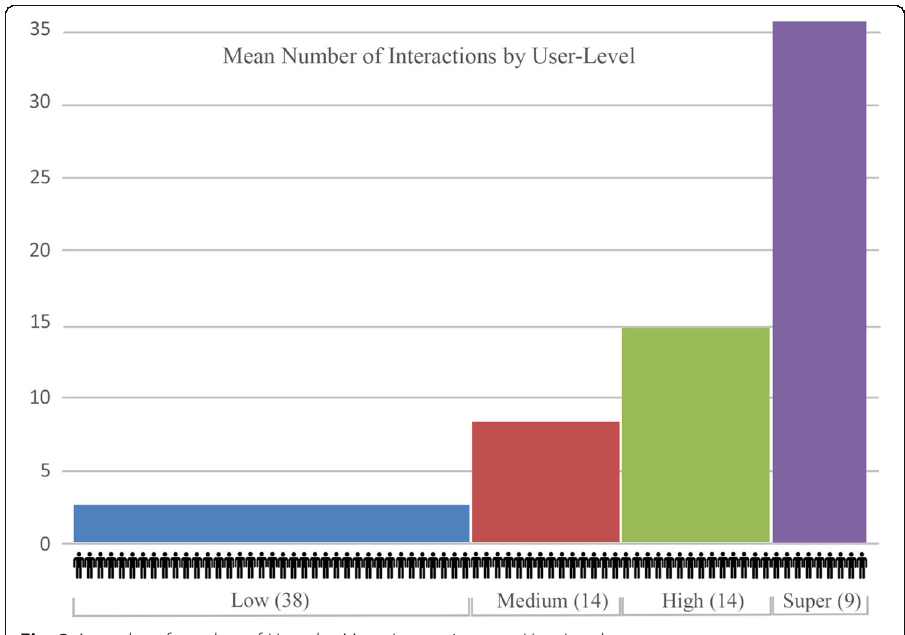
Fig. 3 Area plot of number of Users by Mean Interactions per User-Level